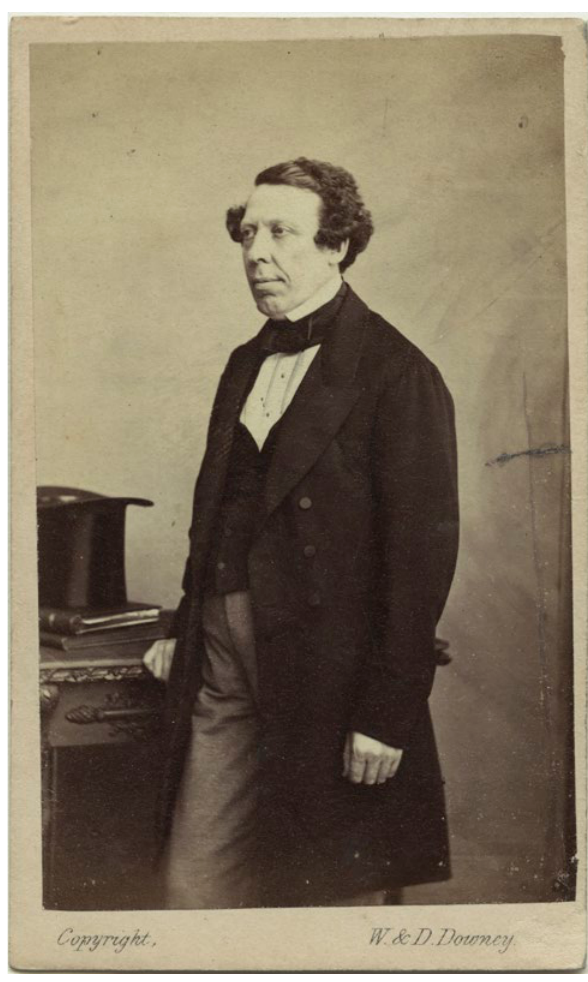
Figure 6. Henry Letheby (1816-1876) [by W. & D. Downey albu- men carte-de-visite, 1860s © National Portrait Gallery,